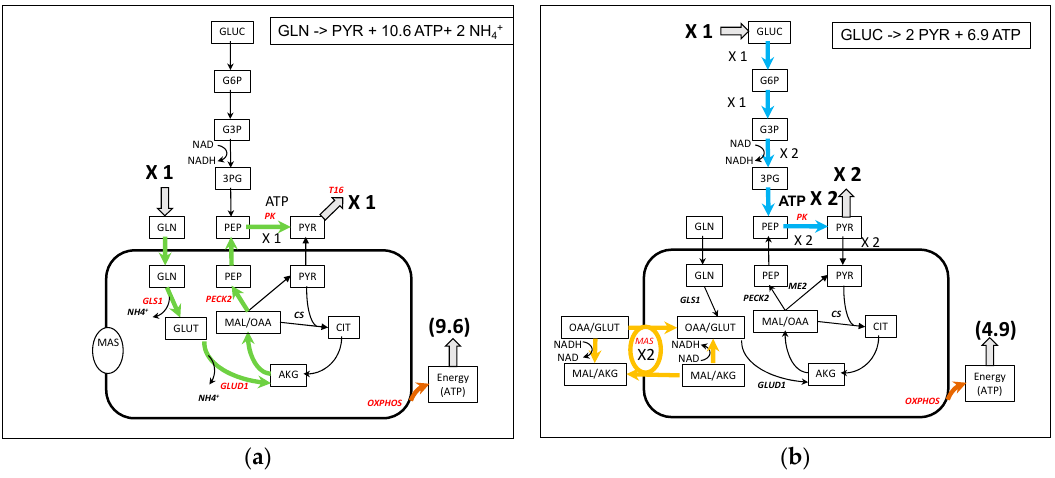
Figure 3. A simplified representation of pyruvate synthesis from glutamine ( a ) and glucose ( b ). Note that in (b), the glycolytic flux and the MAS flux are linked by NAD/NADH cycling. The complete figures of the fluxes are in Figure S3.